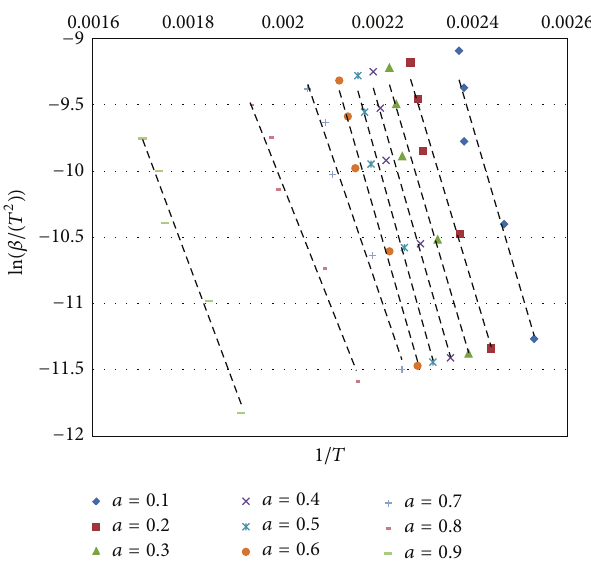
Figure 10: KAS analysis of mcallisterite.